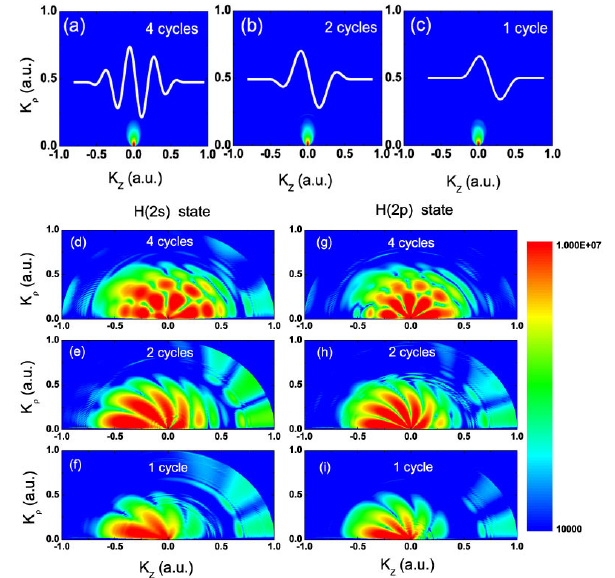
Figure 4. (Color online) PMDs of initial 1 s state ( a – c ), 2 s state ( d – f ) and 2 p state ( g – i ) of a hydrogen atom exposed to a 800 nm laser. The parameters are the same as in Figure 3 but with different pulse